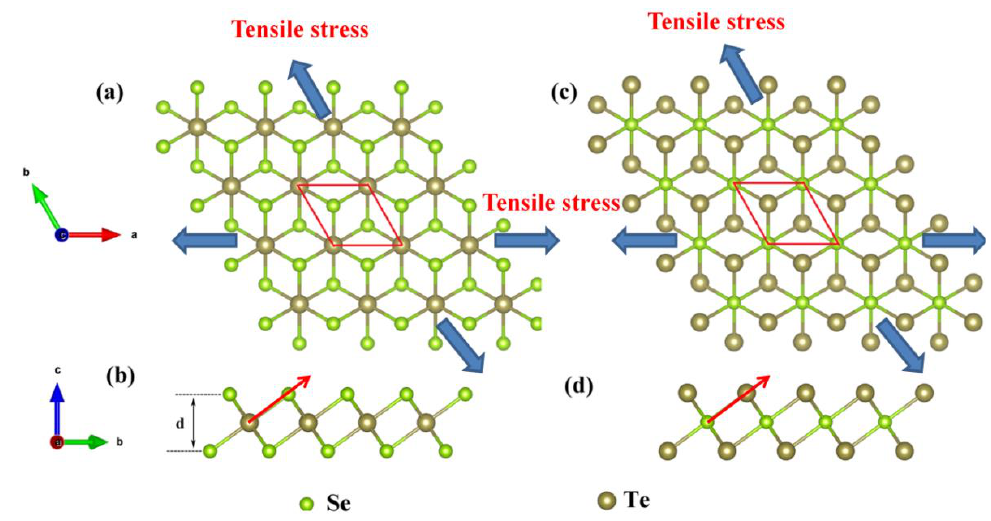
Figure 1. (Color online) Structure diagrams of α -phase Se2Te and SeTe2 monolayers. The ( a ) top and ( b ) side view of the Se2Te monolayers, and ( c ) top and ( d ) side view of the SeTe2 monolayers. The blue arrow indicates the direction of tensile stress. The solid red diamond-shaped box represents the primitive cell. The red arrow demonstrates the direction of the ELF profile.